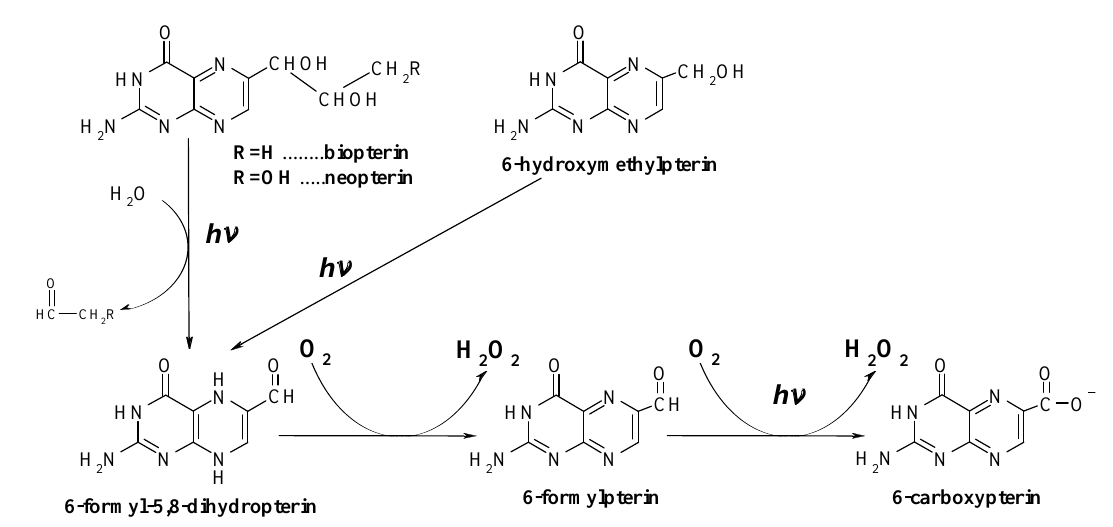
Figure 2. Formation of H formylpterin in aqueous